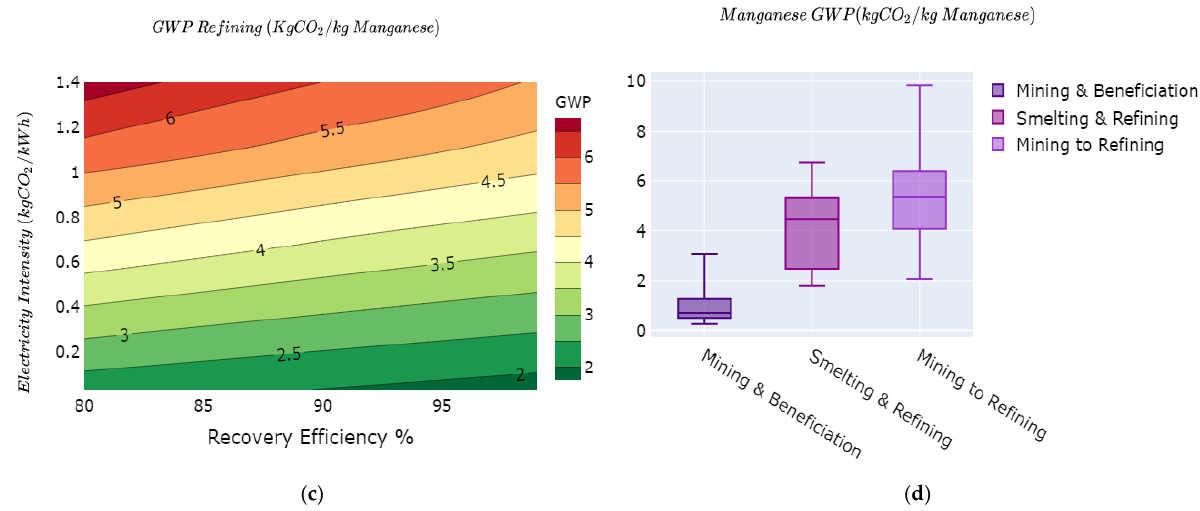
Figure 4. GWP variability on the manganese value chain as functions of: ( a ) ore grade vs. electricity mix intensity; ( b ) recovery efficiency vs. electricity mix intensity; ( c ) smelting recovery efficiency vs. electricity mix intensity; and ( d ) overall GWP variations manganese value chain.